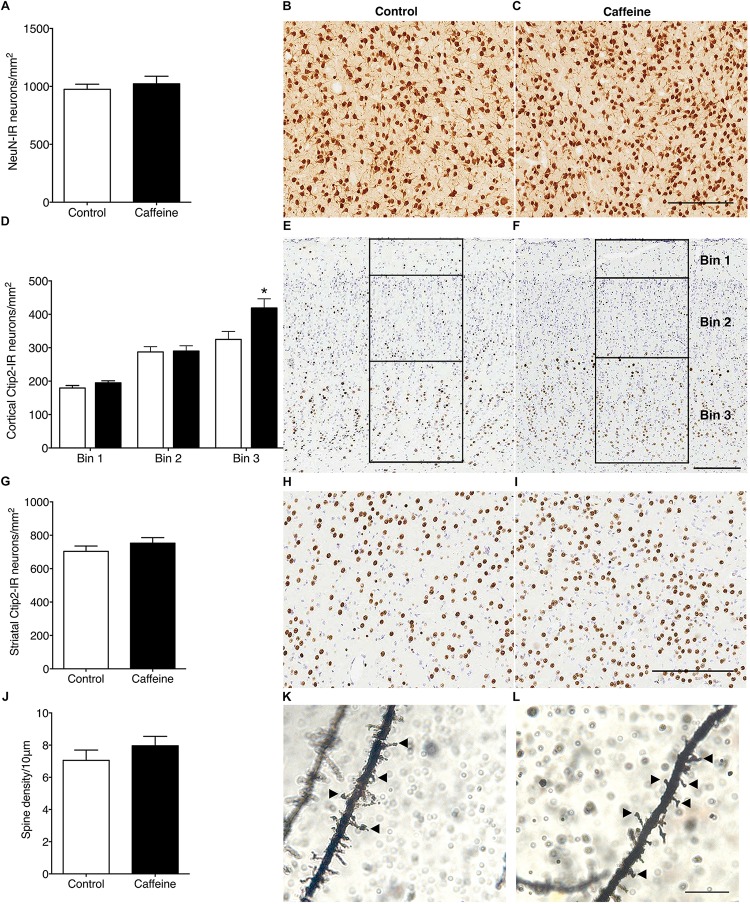
NeuN-IR neurons, Ctip2-IR projection neurons and layer V pyramidal neuron dendritic spine density in control and caffeine-treated fetuses. NeuN-IR neuronal density in the striatum (A) was not different between control and caffeine-treated fetuses, illustrated by comparing images from the striatum in control (B) and caffeine-treated (C) fetuses at 119DG. There was a significant increase in Ctip2-IR projection neurons in bin 3 (layers V and VI) in the cerebral cortex (D), in the caffeine group compared to controls, with no significant differences in all other bins. This is illustrated by comparing images of Ctip2-immunoreactivity in control (E) and caffeine-treated (F) fetuses. Bins were divided according to cortical layers (bin 1: cortical layer I; bin 2: layers II, III, and IV; bin 3: layers V and VI) as shown in (E,F). There was no significant difference between control and caffeine-treated fetuses in Ctip2-IR neuronal density within the striatum (G), illustrated by comparing images from the striatum of control (H) and caffeine-treated (I) fetuses. There was no significant difference between control and caffeine-treated fetuses in dendritic spine density per 10 μm of apical dendrite (J). This is illustrated by comparing high power images of Golgi-cox stained sections from the cerebral cortex in control (K) and caffeine-treated (L) fetuses at 119DG. Arrowheads show dendritic spines on apical dendrites. Scale bar (B,C,E,F,H,I) = 200 μm; (K,L) = 10 μm. *p < 0.05.